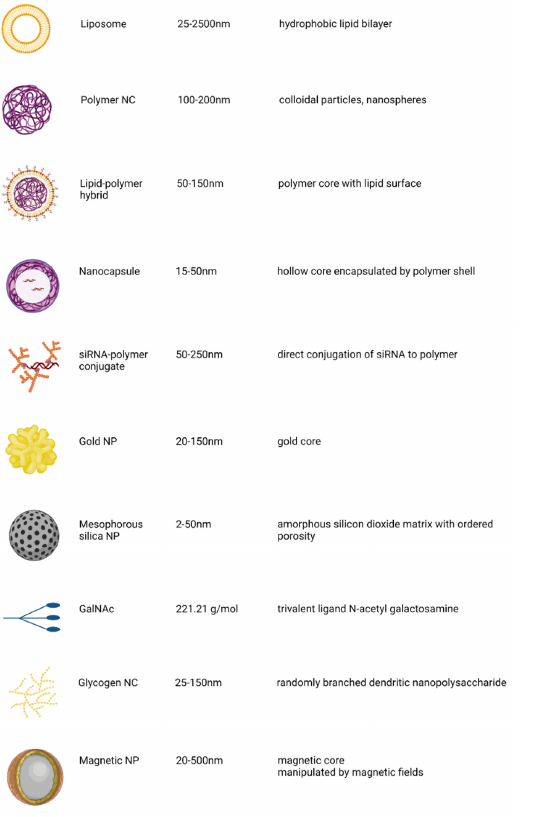
Figure 5. Summary of non-viral delivery systems currently used for nucleic acid delivery. Created with BioRender.com. Table 1. Selected non-viral systems used for delivery of RNA therapeutics in clinical trials and pre- clinical development. Non-Viral System